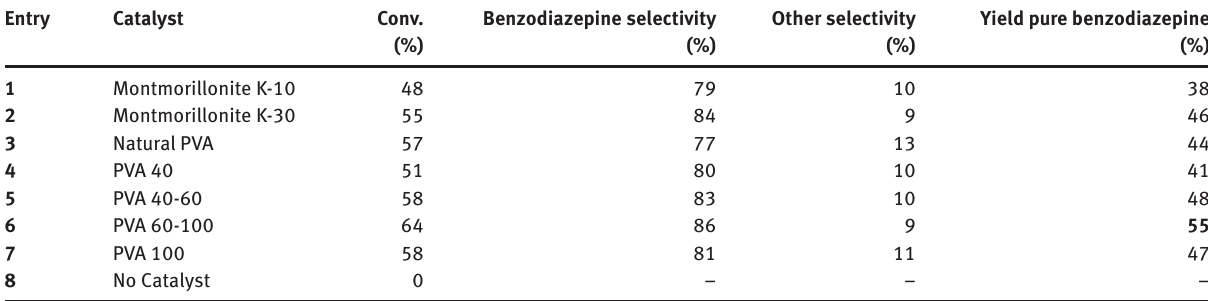
Table 3: Catalyst effect.